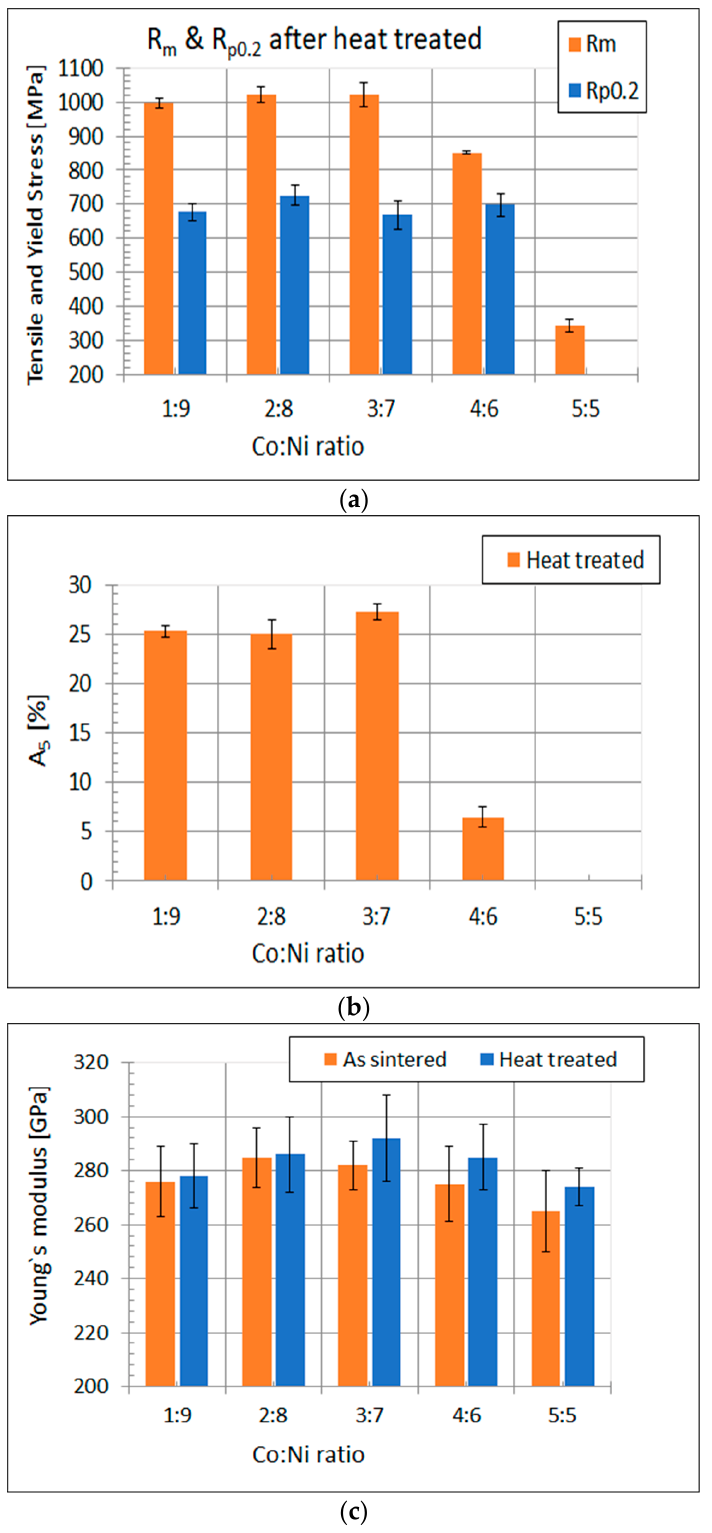
Figure 8. The changes of properties: ( a ) tensile strength and yield strength; ( b ) elongation; ( c ) Young’s modulus with a Co to Ni ratio.